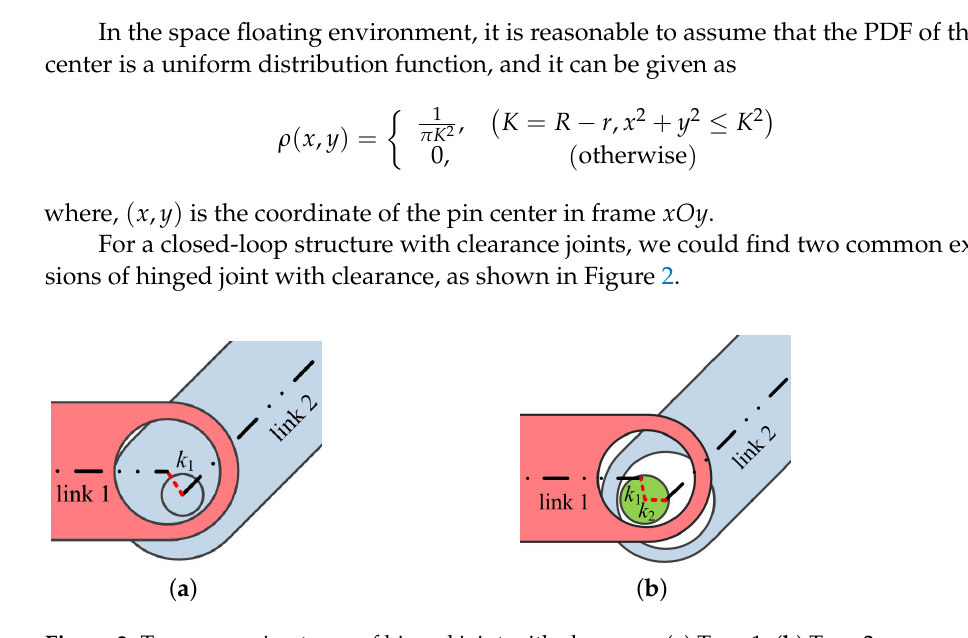
Figure 2. Two expression types of hinged joint with clearance. ( a ) Type 1. ( b ) Type 2.